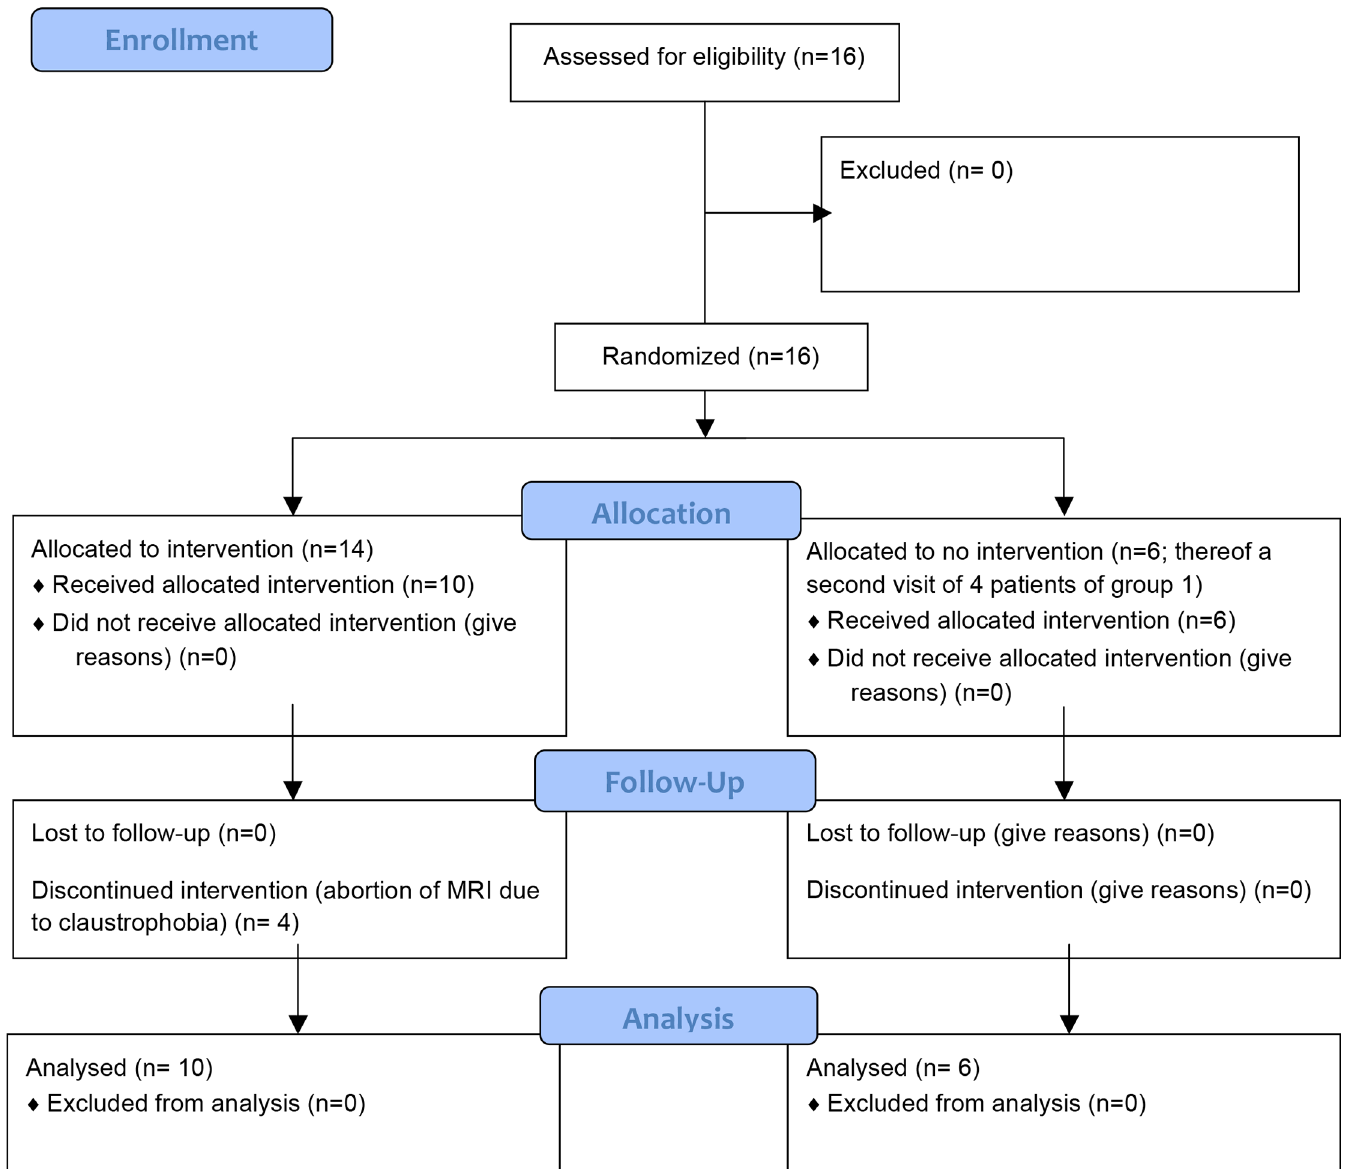
Fig 1. Patient cohort (CONSORT flow chart). Please note: For the control group a second visit of 4 patients of the treatment group were includedresulting in 20 visits of 16 patients. oxygen was administered at a flow rate of 15 L/min using a full closed face mask (Air Cushion Face Mask Size 3 or 4, VBM Medizintechnik, Sulz, Germany) with a filter (MicroGard II, Care- Fusion, Hoechberg, Germany) and a 2L reservoir (SPUR II, Ambu A/S, Ballerup, Denmark) [23]. T1 maps were calculated as previously described [13,23,24]: Registration of the individual magnitude images obtained at 100% oxygen onto room air images was performed by using a nonrigid registration algorithm (Advanced Normalization Tools (ANTS); http://stnava.github. io/ANTs/ [25]). Afterwards T1 maps were calculated from the magnitude images by using a nonlinear fit [24] within a self-developed Matlab script [23](MATLAB 2012a, MathWorks, Natick, Mass). After manual segmentation, excluding the great central vessels, median T1 at